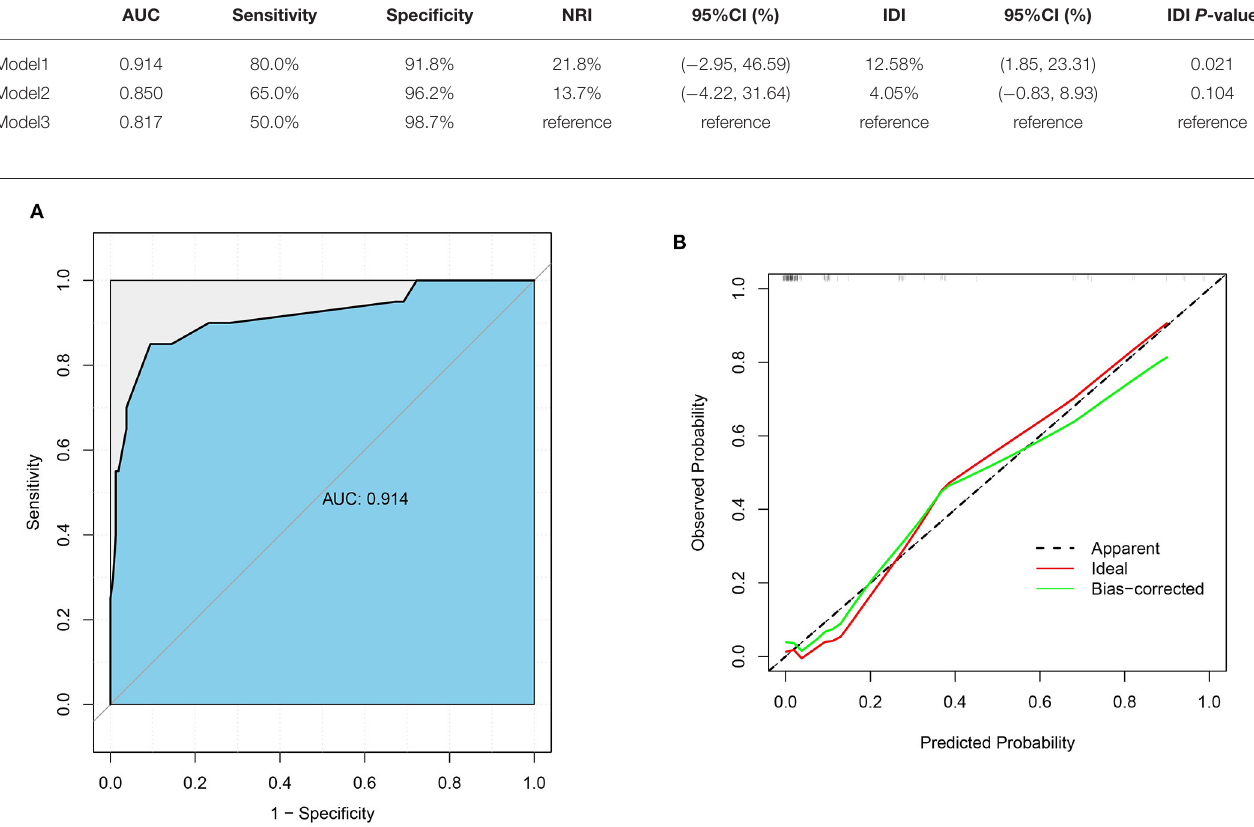
FIGURE 3 | (A) ROC Curve Area of Prediction Model. (B) Calibration Curve of Nomogram